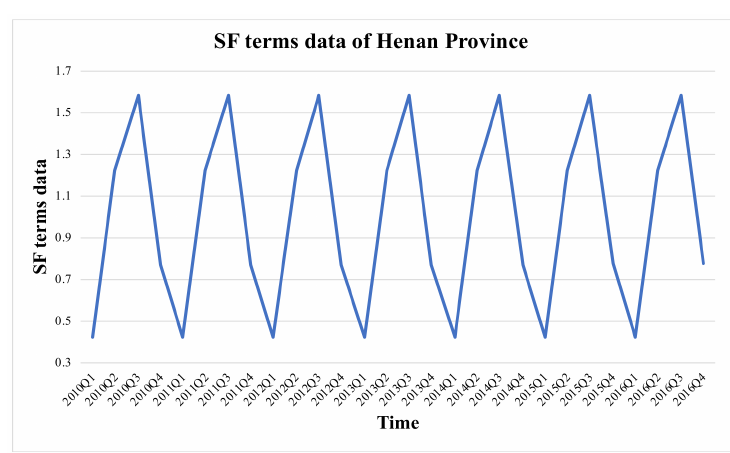
Figure 13. SF terms data of Henan Province.